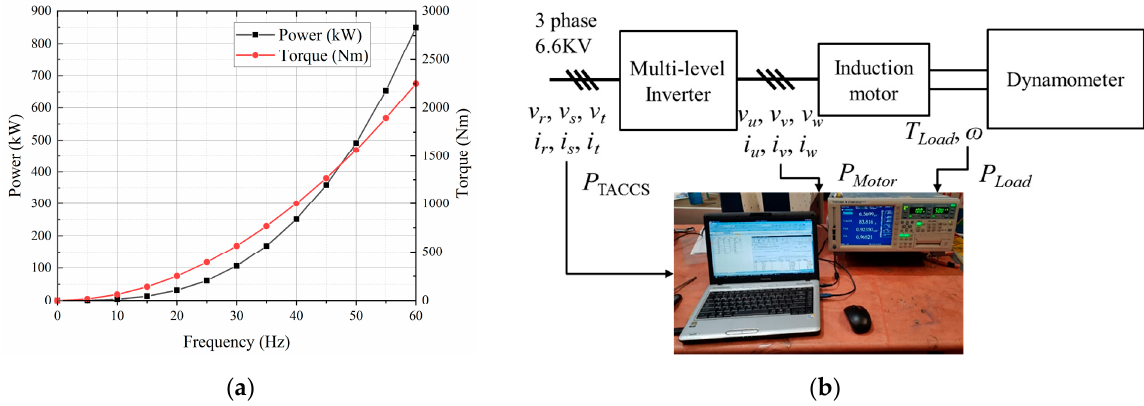
Figure 2. Experimental configuration for performance evaluation of the electric motor drive system (EMDS) according to load curves. ( a ) Ideal load curves; ( b ) diagram of experimental configuration.